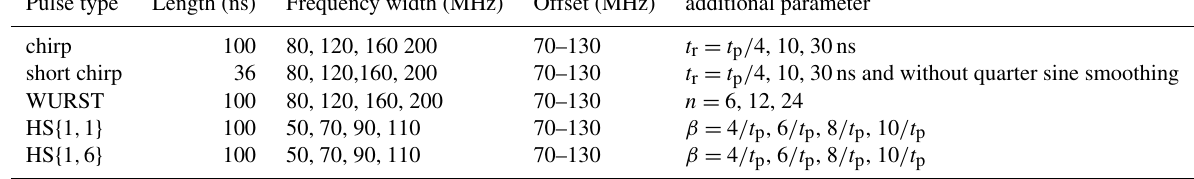
Table 2. The parameters for the broadband-shaped pump pulses.